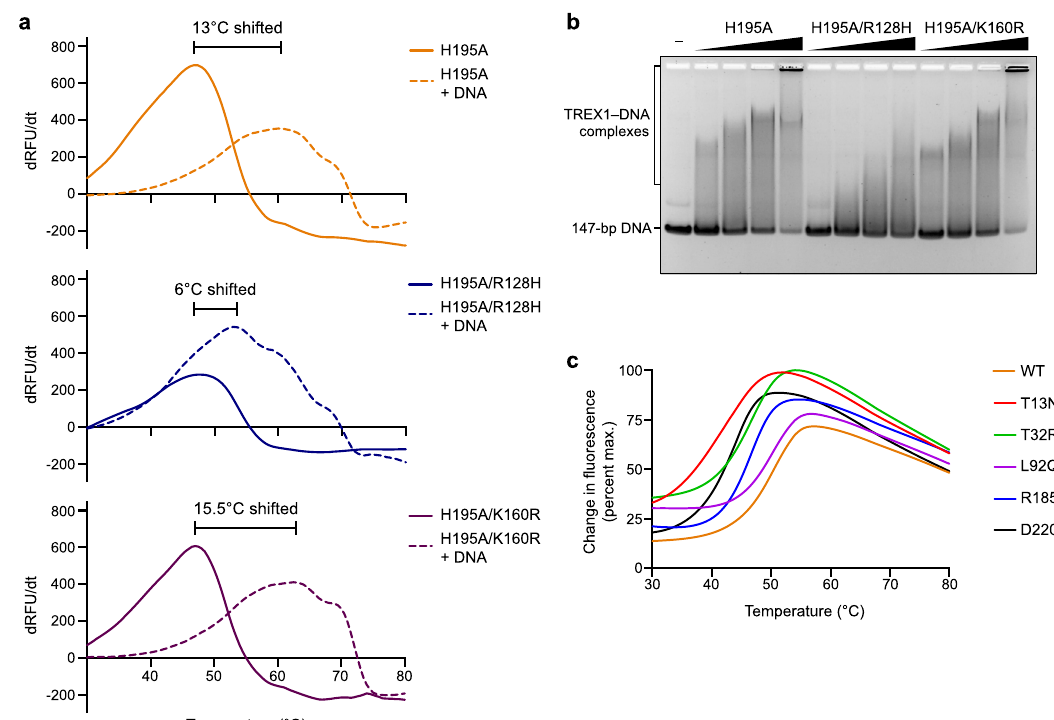
Fig. 5 | AnalysisofhTREX1substitutionsonDNA-binding and protein stability. a Thermo fl uor analysis melting curves measuring hTREX1-DNA stable complex formation. Disease-associatedmutations R128Hand K160Rexhibitabnormal DNA- bindingcomparedtoWThTREX1.Dataarerepresentativeofatleast3independent experiments. Source data are provided as a Source Data fi le. See also Supplemen- tary Fig. 7c. b In vitro electrophoretic mobility shift assay measurement of